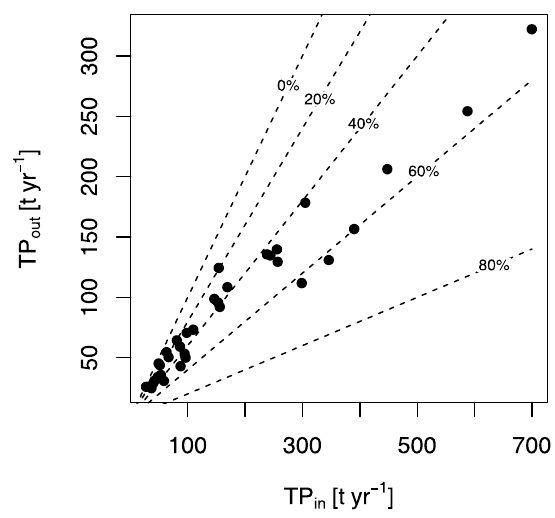
Figure 9. Outflowing flux of TP (TP out ) as a function of inflowing TP flux (TP in ) for the entire system. Isolines show constant retention rates.